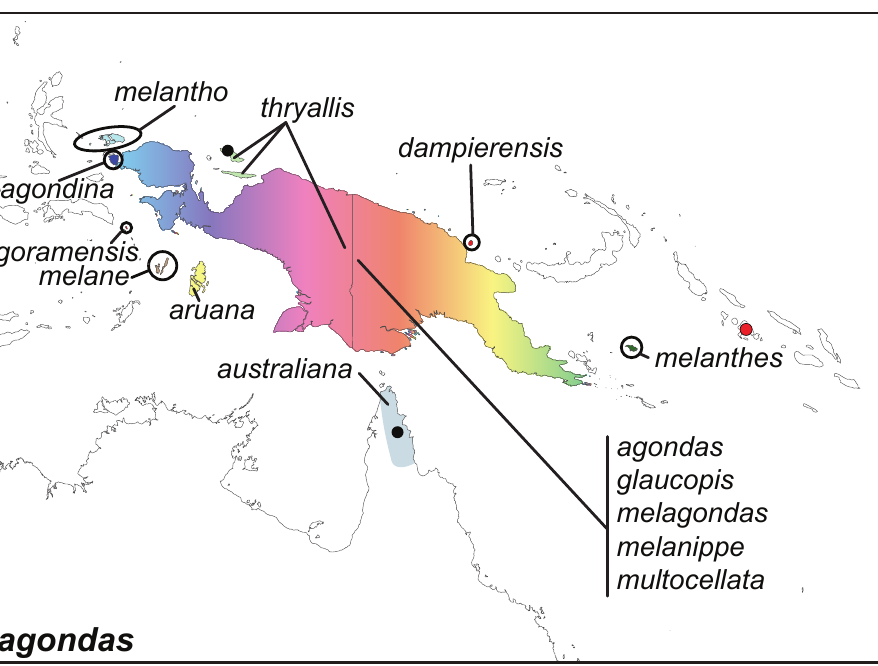
Figure 66. Distribution map of Elymnias agondas